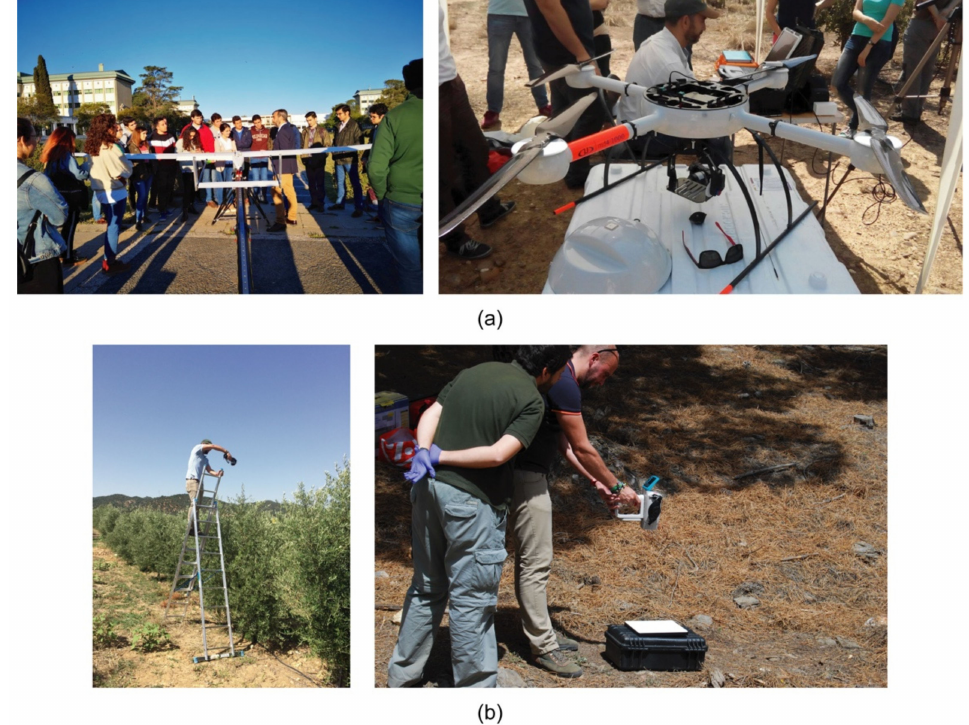
Figure 6. Some teacher-guided activities: ( a ) learning about UAV platforms and ( b ) fieldwork to measure temperature and spectral signature for atmospheric